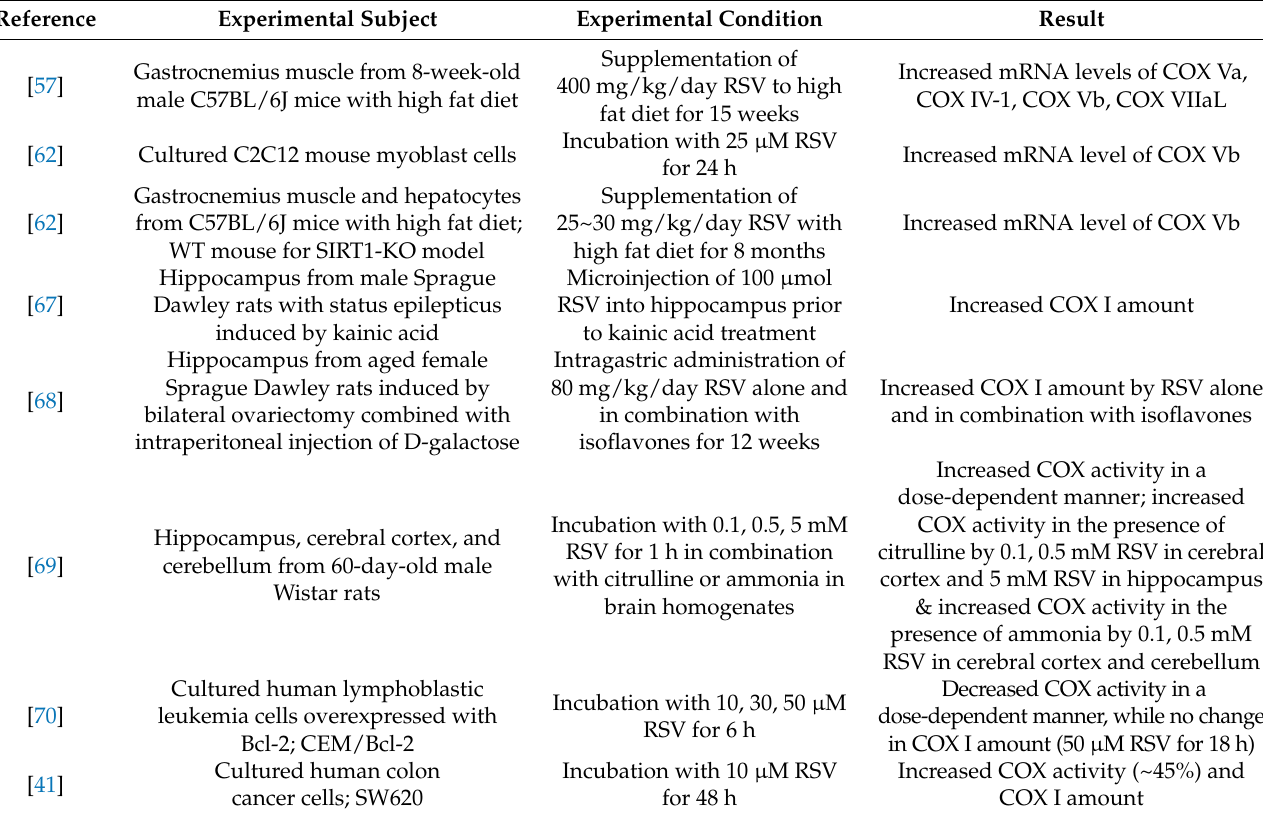
Table 1. Effect of resveratrol (RSV) administration on cytochrome c oxidase (COX).